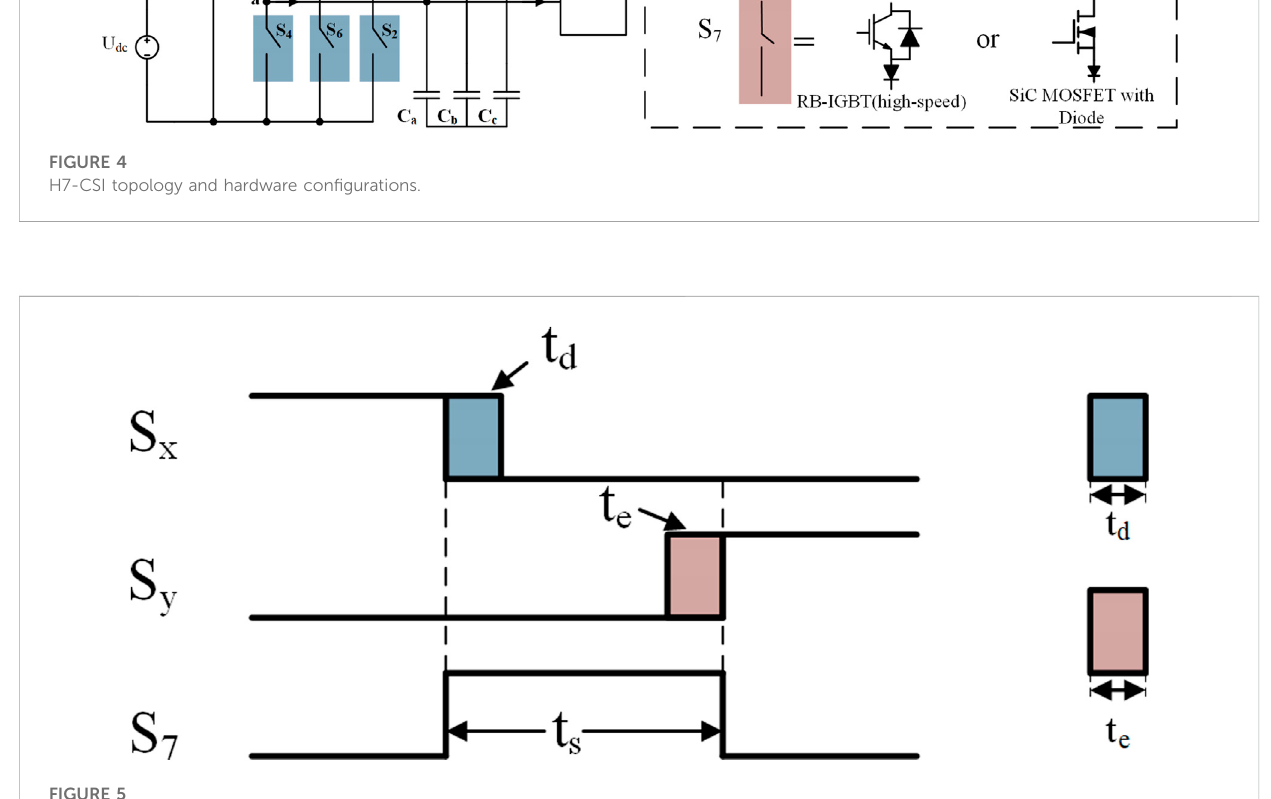
Overlap-time optimization